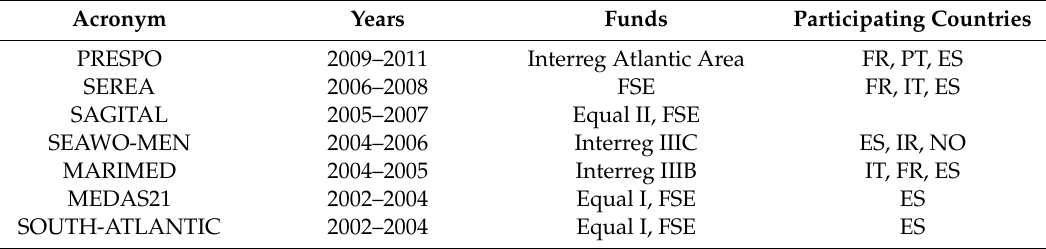
Table 1. Projects related to fishing tourism in Spain and